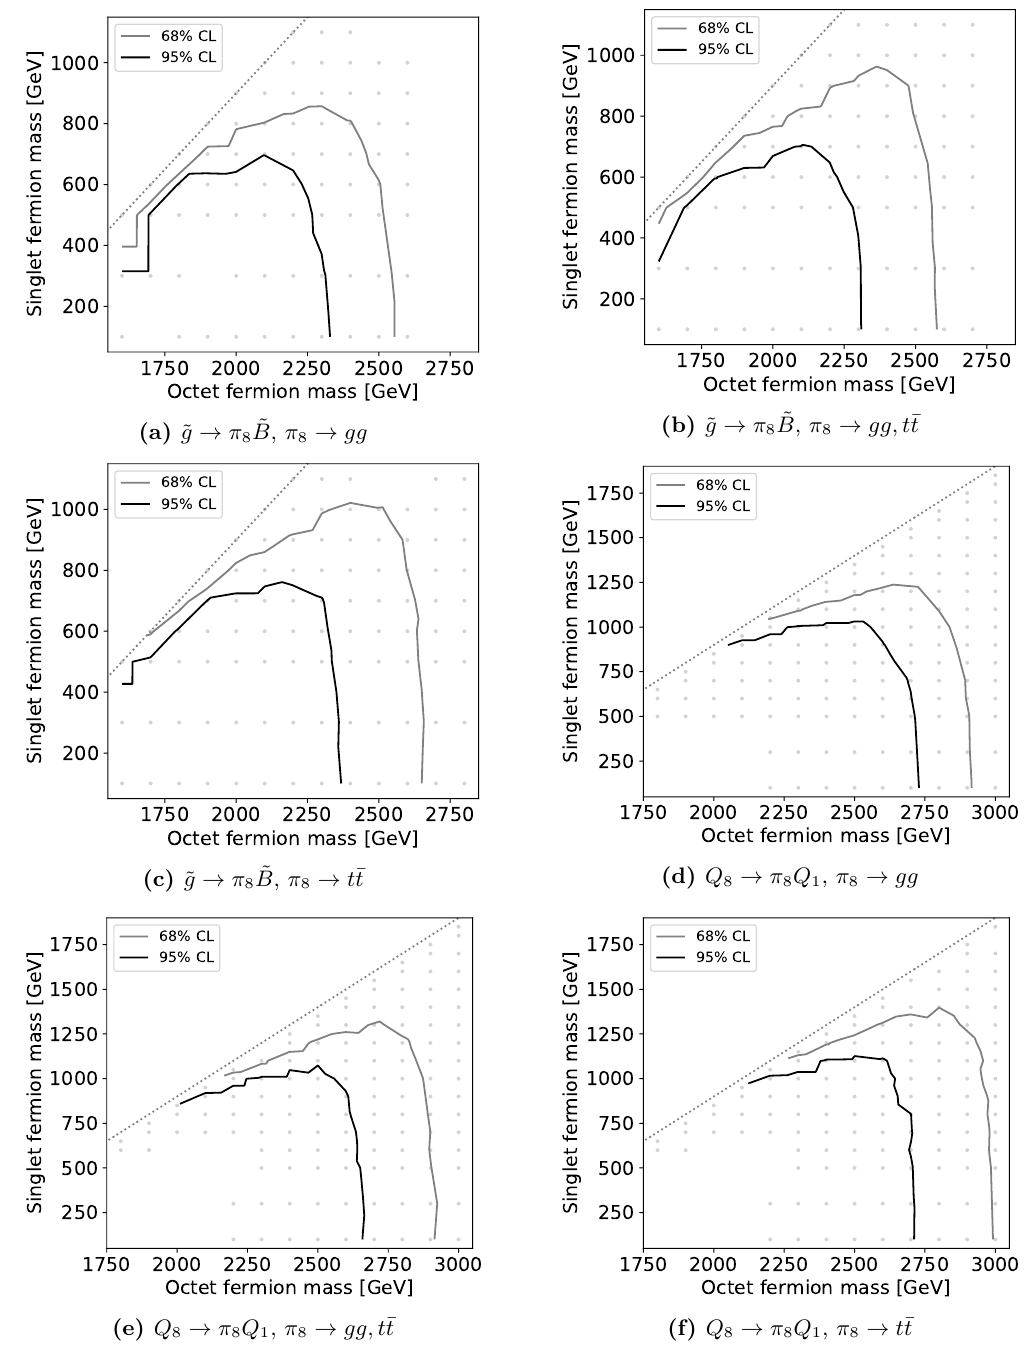
(a) ˜ g → π 8 ˜ B , π 8 → gg (b) ˜ g → π 8